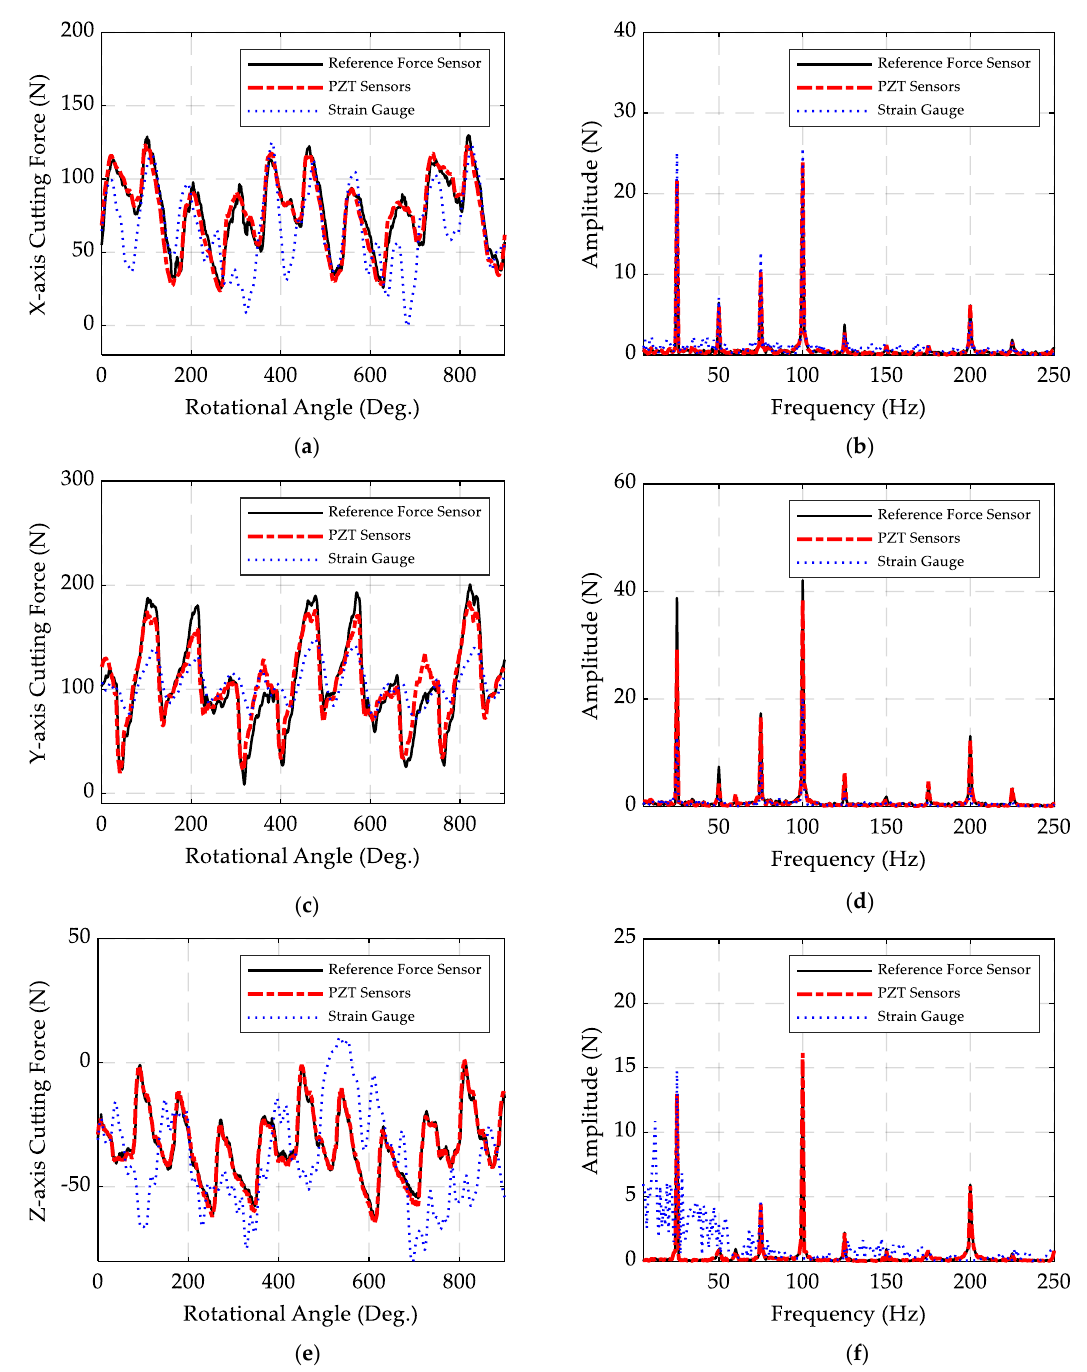
Figure 19. ( a ) Cutting forces measured in the X direction, ( b ) the fast Fourier transform (FFT) of the measured X -axis forces, ( c ) cutting forces measured in the Y direction, ( d ) the FFT of the measured Y -axis forces, ( e ) cutting forces measured in the Z direction, ( f ) and the FFT of the measured Z -axis